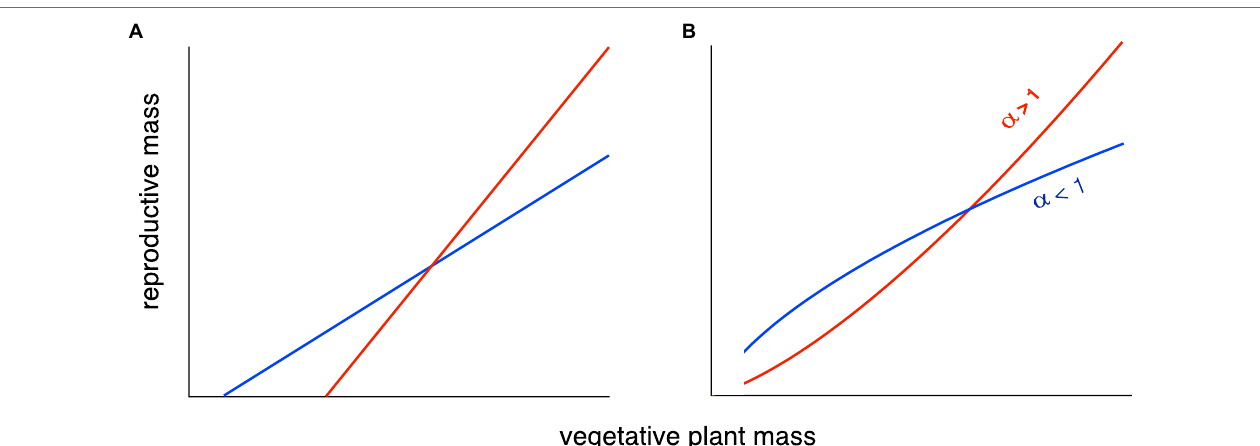
FIGURE 1 | Two versions of two types of allometric relationship between plant reproductive output (yield) and size [after Weiner et al. (2009) and Bonser (2020)]. (A) A linear relationship with a positive X-intercept (minimum size for reproducing). (B) A classical allometric relationship, Y = β X α . In both cases, there is a tradeoff between the maximum reproduction at large size and reproduction at smaller sizes. The red lines result of selection for maximal performance under good conditions, as in the breeding of high-yielding varieties for high-input agriculture. The blue lines result from a “bet-hedging” (risk reduction) strategy to reduce the probability of a very bad outcome. The latter strategy will be advantageous when there is large temporal and/or spatial variation in conditions, including some very unfavorable conditions, and is the most appropriate strategy for smallholder farmers in developing countries. The tradeoff can be visualized as a constraint on the area under the curve.